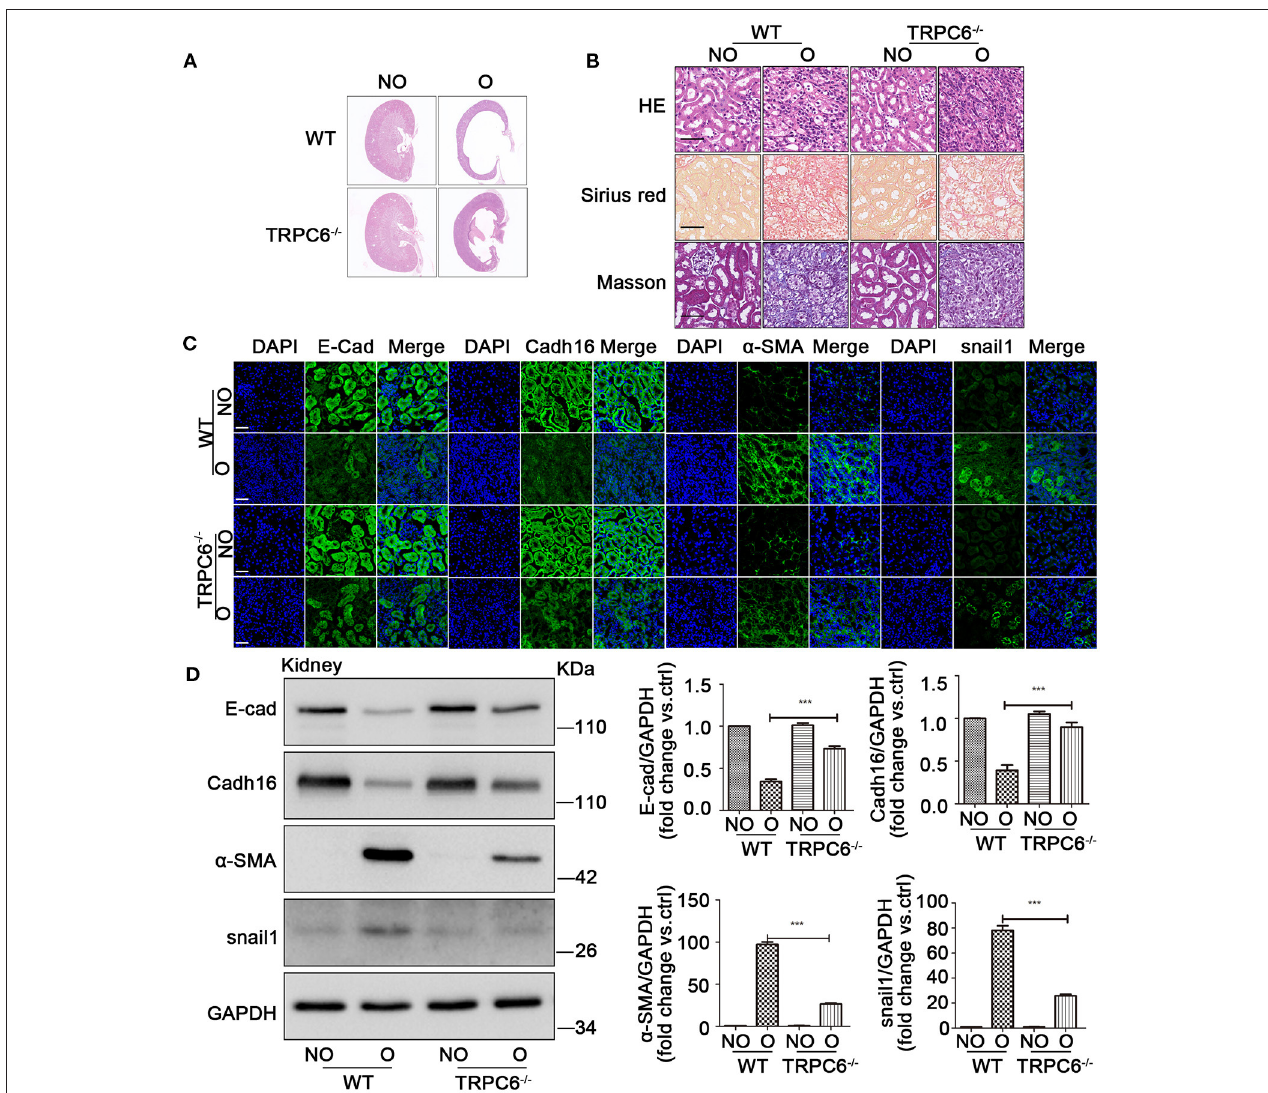
FIGURE 2 | TRPC6 knockout partially inhibits EMT to alleviate the kidney injury. (A) Representative scanning images of kidney coronal plane showing the cavity caused by fibrotic injury in NO and O kidneys from TRPC6 knockout and WT mice on day 15 after UUO. (B) Representative images of kidney sections stained by HE, Masson, and Sirius red showing interstitial fibrosis change of kidney tissues from the above groups. Scale bars, 20 µ m. (C) Expression level of EMT markers (green) E-cad, Cadh16, α -SMA, and snail1 as well as nuclear stain DAPI (blue) from the above groups detected by immunofluorescence analysis. Scale bars, 20 µ m. (D) Expression level of EMT markers E-cad, Cadh16, α -SMA, and snail1 in NO and O kidneys from the above groups detected by western blot. Data are presented as mean ± sem, n = 3; an unpaired two-tailed t -test was used. *** P <